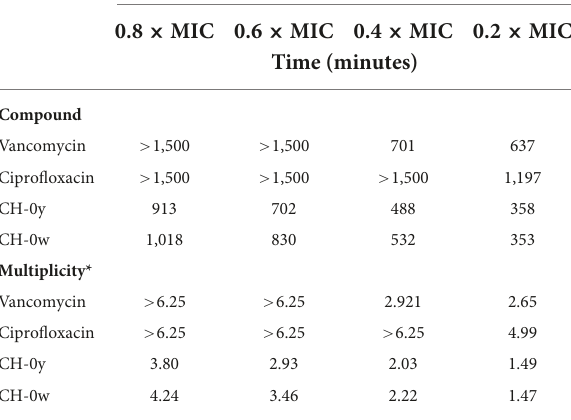
TABLE 4 Post-antimicrobial sub-MIC effect presented as a time delay in the growth of a bacterial strain after 2 h of exposure to CH-0y, CH-0w, and the conventional drugs, vancomycin, and ciprofloxacin in concentrations corresponding to 1 × MIC, with subsequent cultivation in a medium with sub-inhibitory concentrations of the included